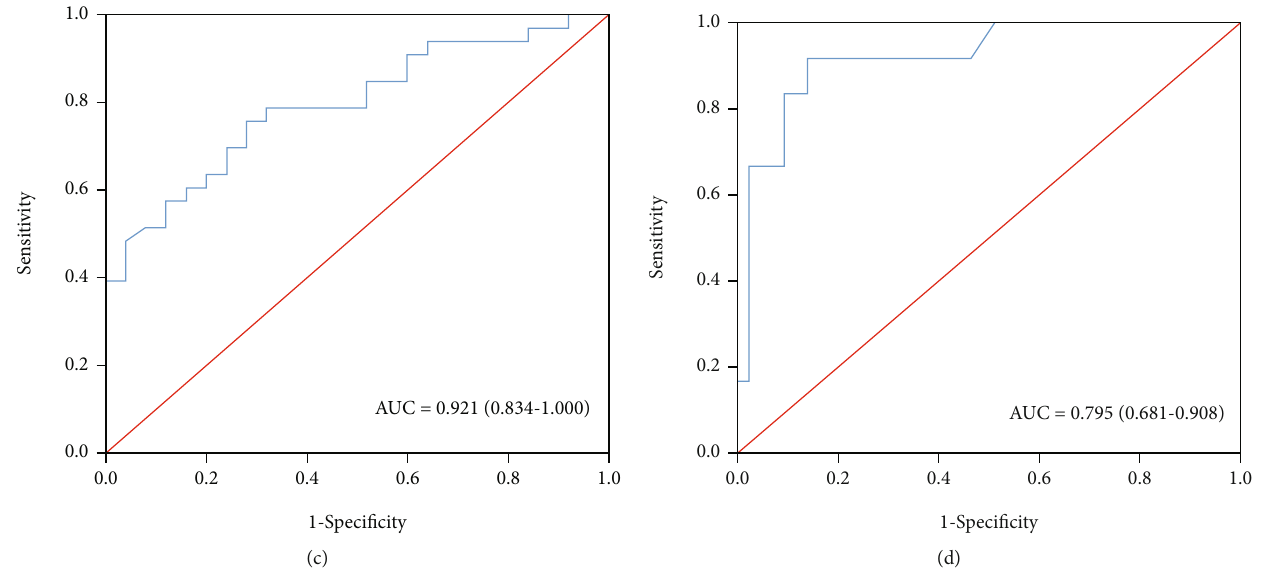
Figure 3: Performance of the nomogram in the validation cohorts. Calibration curve of the nomogram in the internal (a) and external (b) validation cohorts. The 45 ° dotted line represents an ideal prediction, and the solid line represents the bias-corrected predictive performance of the nomogram. The closer the solid line fi ts the ideal line, the better the predictive accuracy of the nomogram; ROC curves of the nomogram in the internal (c) and external (d) validation cohorts,